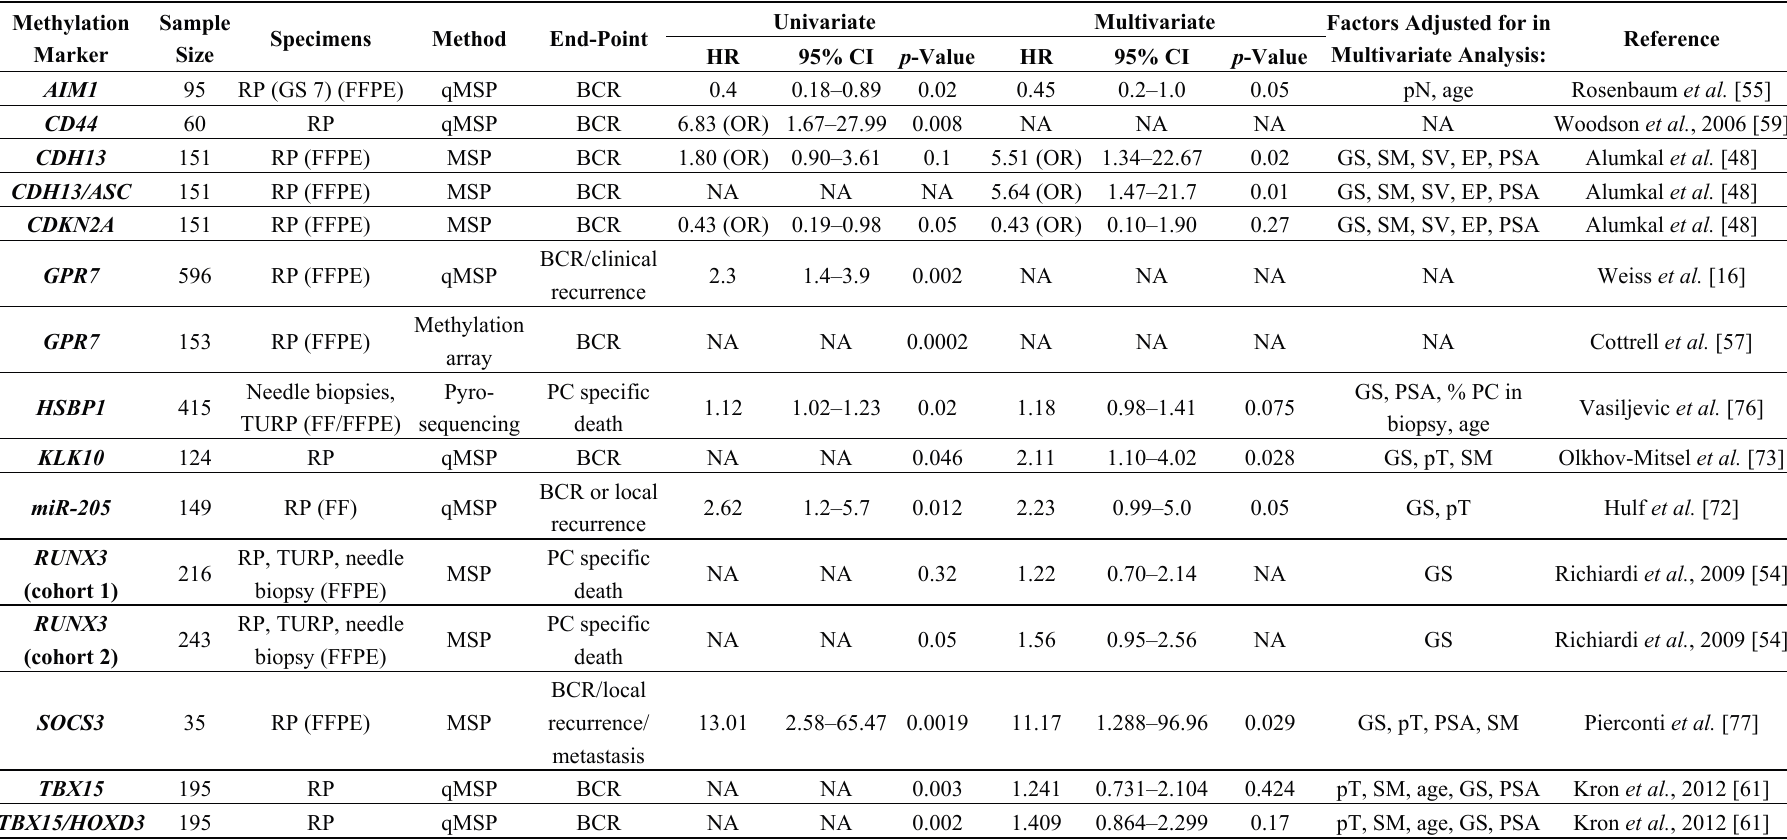
vesicle involvement; pN: Pathological lymph node